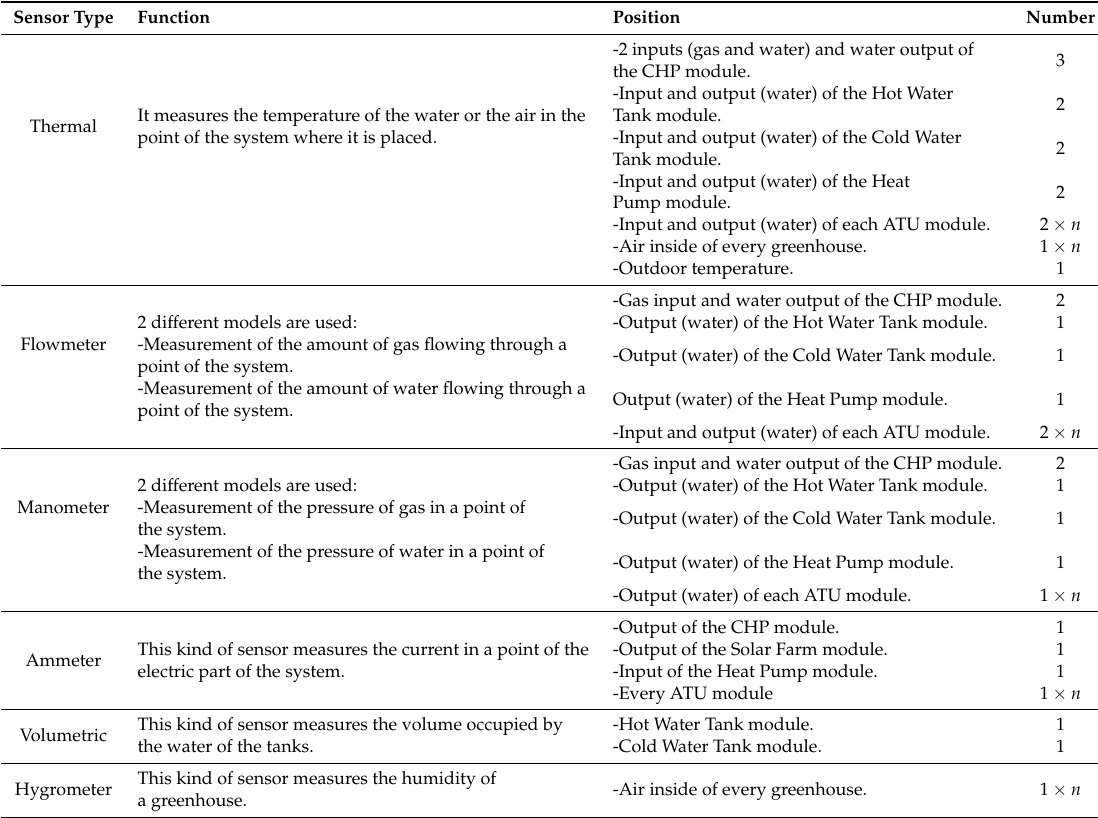
Table 2. Sensors used in the